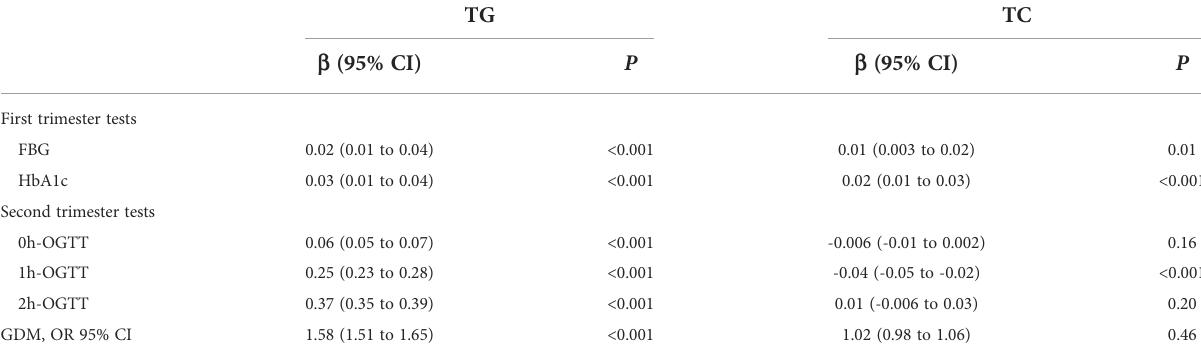
TABLE 2 Association of triglycerides and serum total cholesterol levels with glucose measurements and gestational diabetes mellitus risk. TG TC